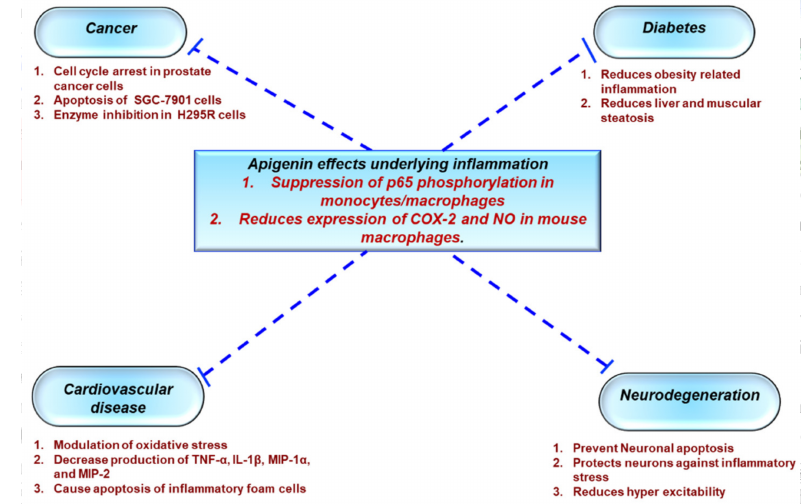
Figure 2. Role of apigenin in chronic inflammatory diseases. Apigenin as an anti-inflammatory compound acts as a protective agent in several disorders via inhibition of key inflammatory mediators, signaling pathways, and molecules. COX-2—cyclooxygenase-2; IL—interleukin; TNF—tumor necrosis factor; NO—nitric